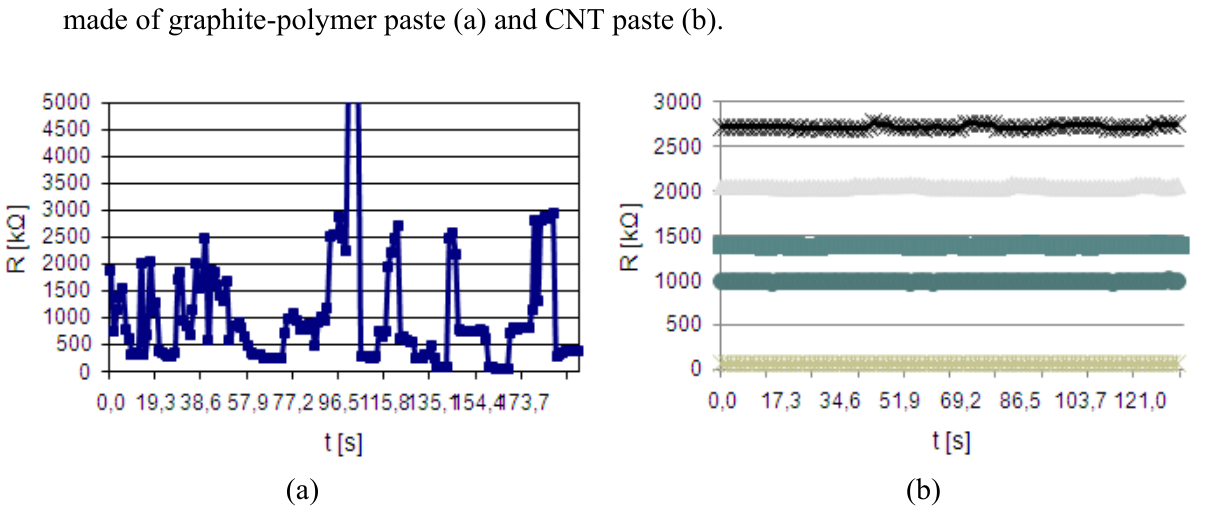
Figure 10. The influence of dynamic mechanical stress on temperature sensors resistivity made of graphite-polymer paste (a) and CNT paste